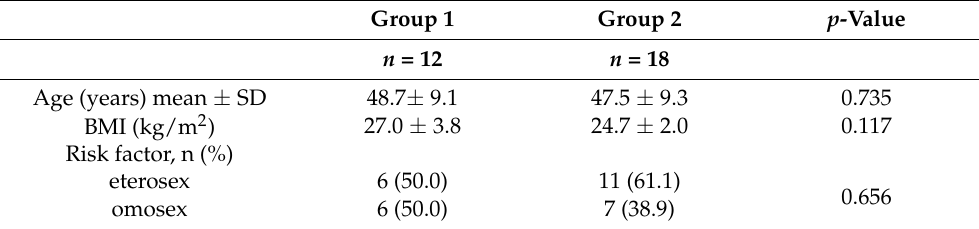
Table 1. Baseline characteristics of patients. p -values are shown in